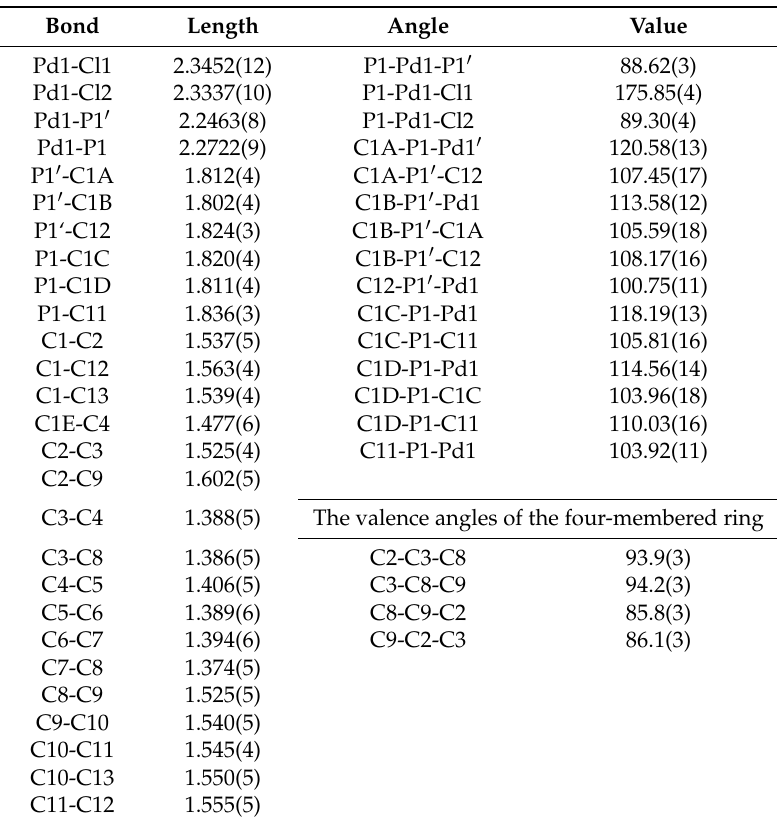
Table 2. Bond lengths (Å) and valence angles ( ◦ ) for [Pd( 6q )Cl 2 ]. Bond